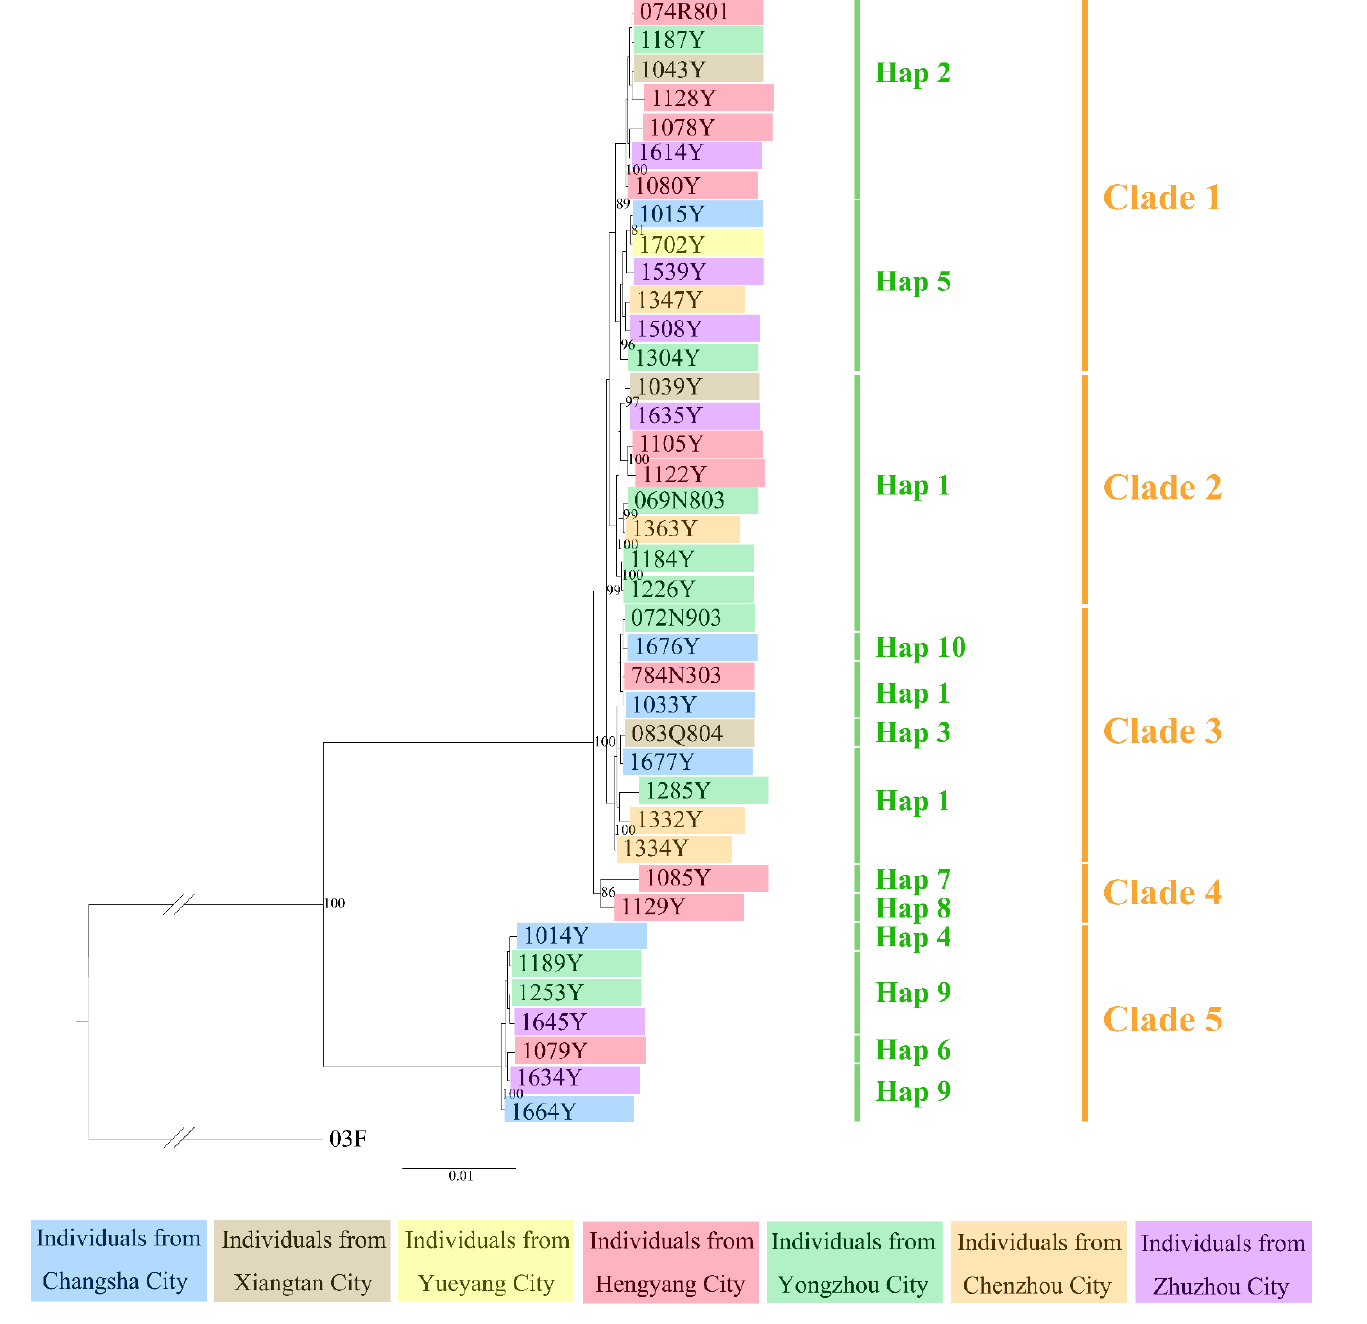
Figure 2. Phylogenetic trees, reconstructed using Bayesian phylogeny estimation, based on COI + COII + 12S + 16S + ND1 genes. Bayesian posterior probabilities (pp ≥ 0.95) are shown on the branches. Amynthas pectiniferus (03F) was used as the outgroup taxon.